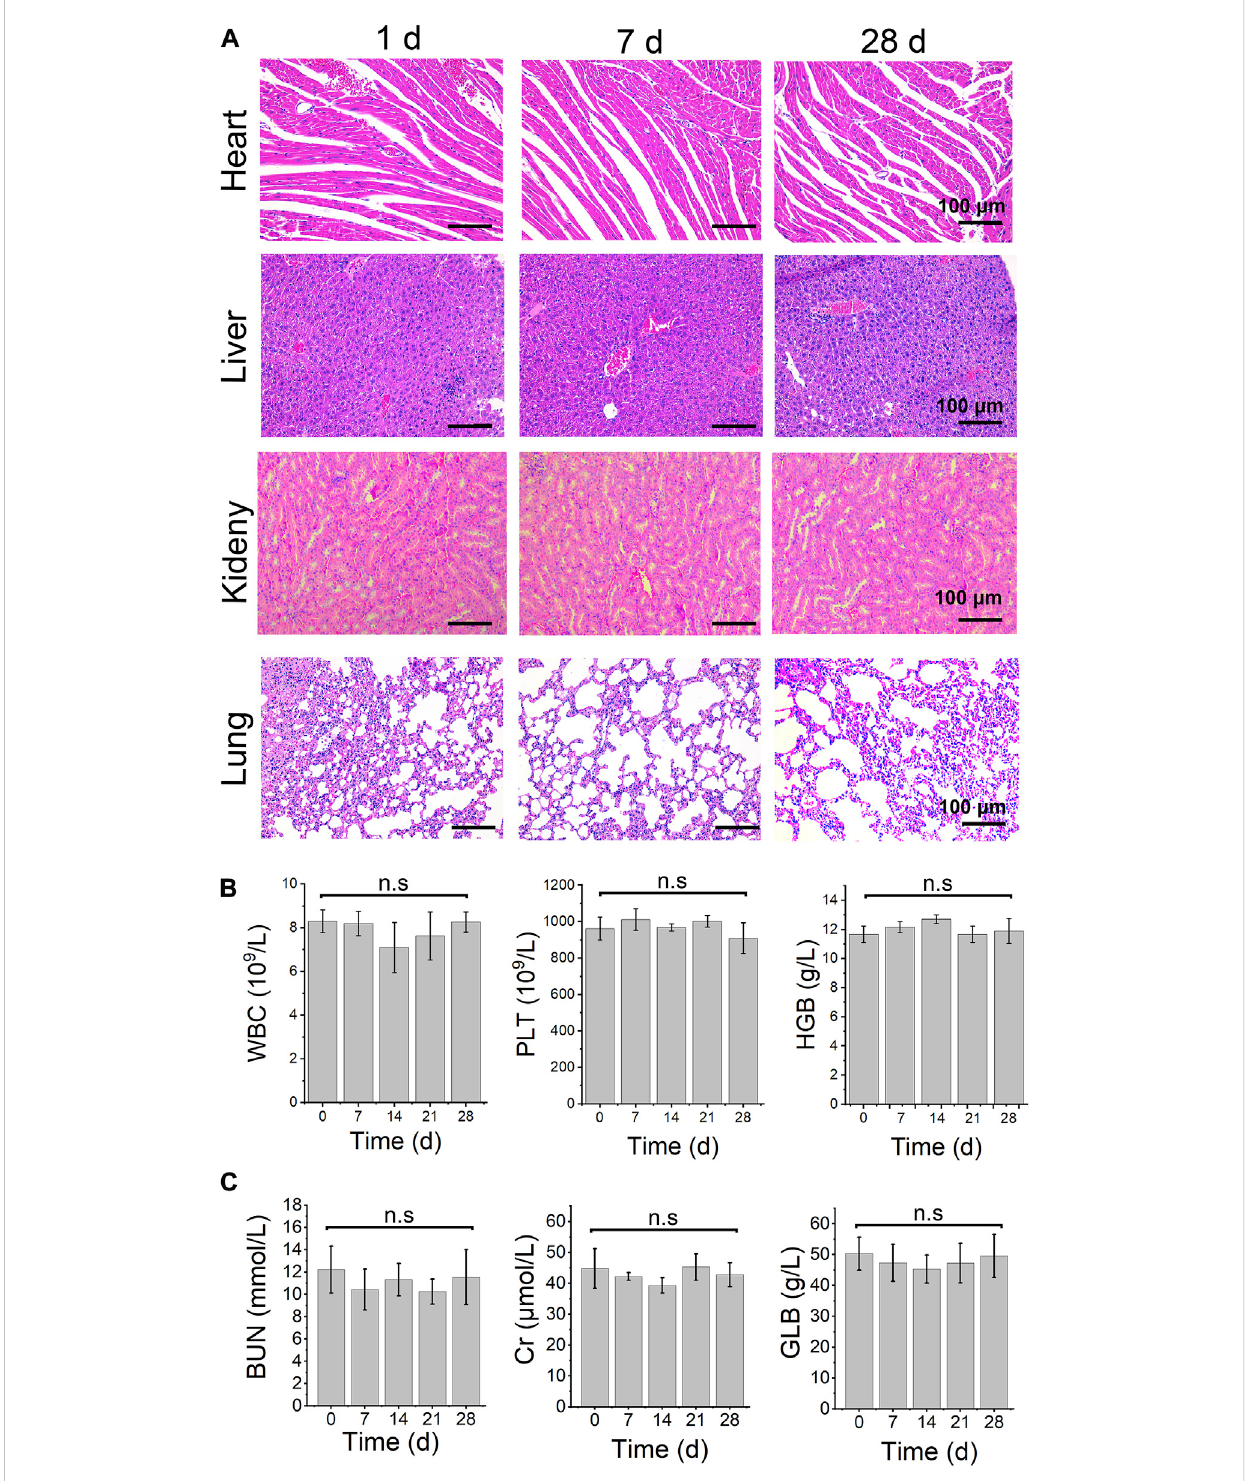
FIGURE 6 safety evaluation. (A) H&E staining images in main organ tissues of TiO 2 − x @GL combined with laser and US irradiation on days 1, 7, and 28. Blood routine examination (B) and biochemical parameters (C) of TiO 2 − x @GL combined with laser and US therapy from day 0 to day 28. WBC: white blood cell; PLT: platelet; HGB: Hemoglobin; BUN: urea nitrogen; Cr: Cr-reactive protein; GLB: